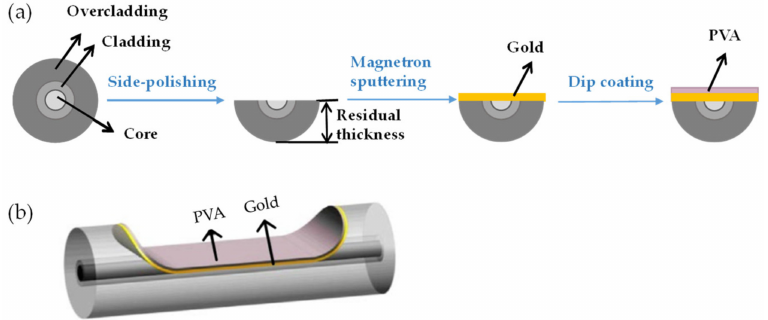
Figure 2. ( a ) Fabrication processes of the PVA-coated RH sensor in cross-sectional views. ( b ) 3D schematic view of the proposed sensor.